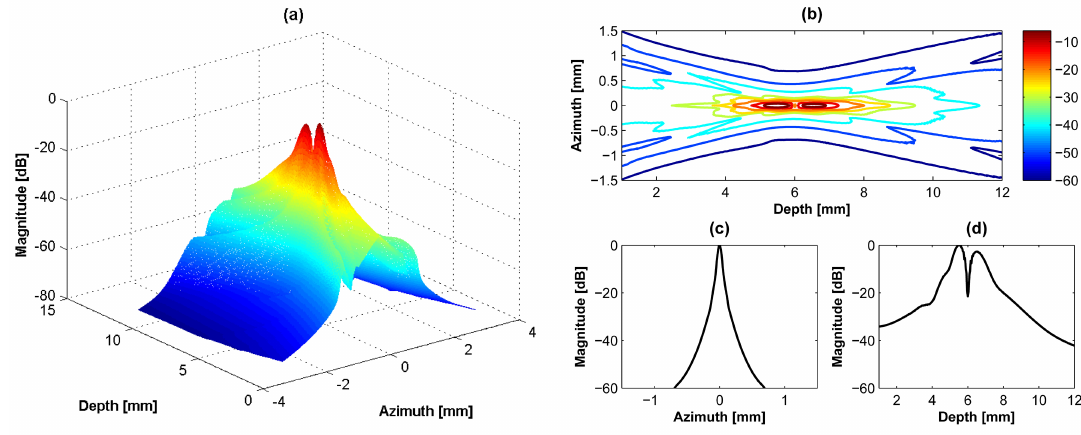
Figure 3. Simulation about dual-element transducer with phase-inverted excitation: ( a ) 3D transmit beam profile, ( b ) 2D transmit beam distribution, ( c ) lateral beam plot, and ( d ) axial beam plot. Note that the color bar in (b) indicates the intensity value in decibel scale and applied to (a). (c) and (d) are obtained from the maximal intensity at the first focal lobe (5.5 mm). The position of the transducer is on the azimuth direction in (a).